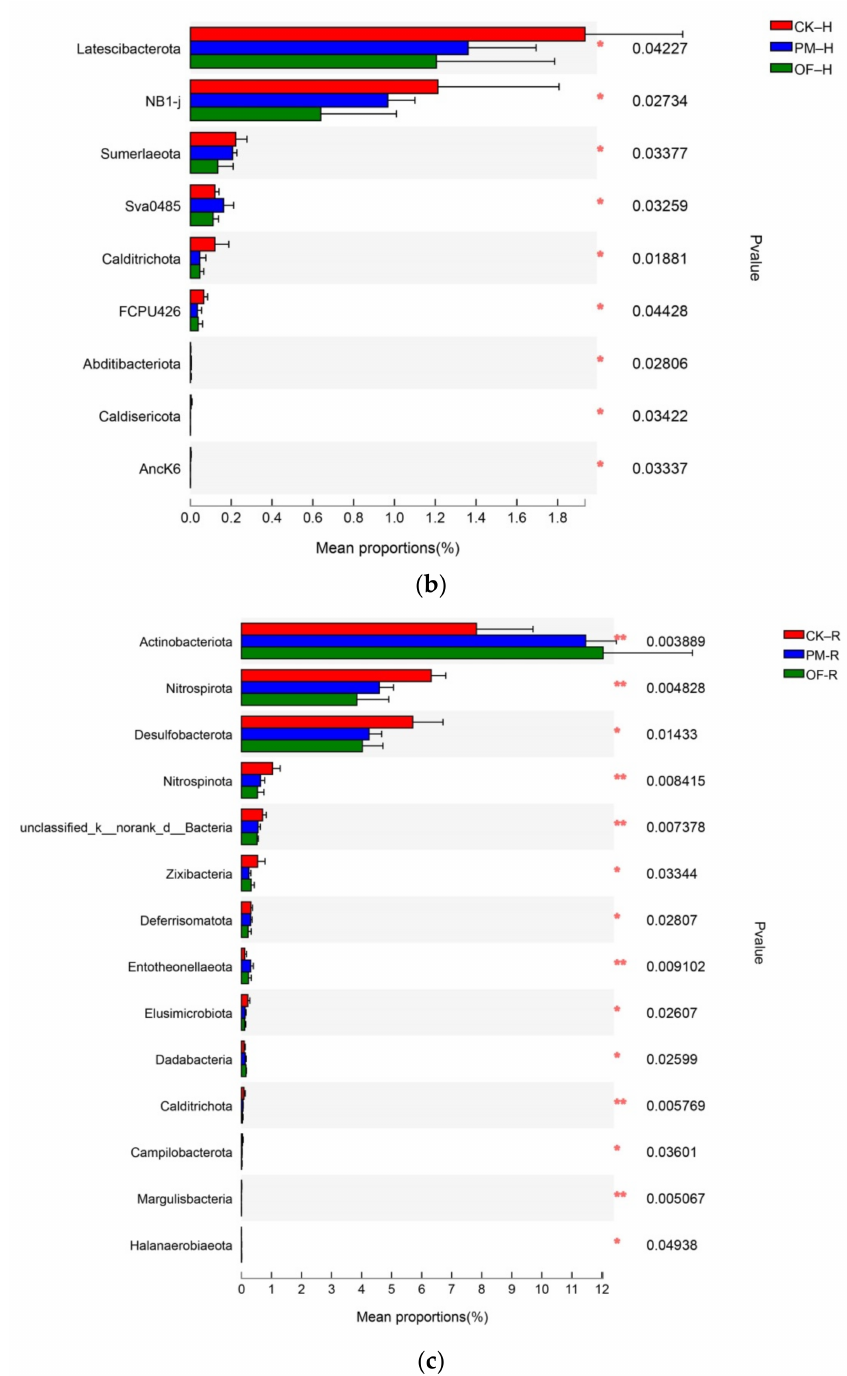
Figure 4. The comparison of differential bacteria between treatment tests based on the relative abundance at phylum level ( a ) tillering stage; ( b ) heading stage; ( c ) ripening stage (* p < 0.05; ** p < 0.01; *** p <